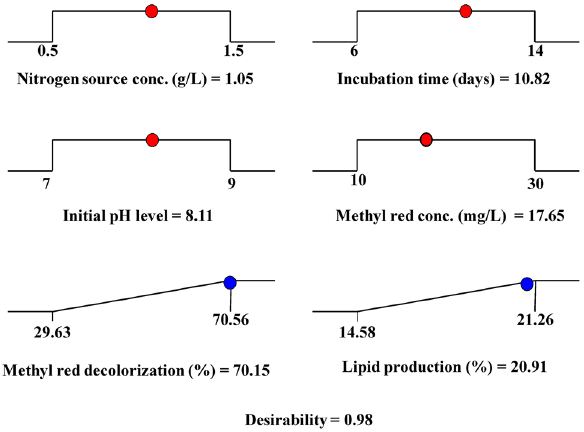
Figure 6. The optimization plot displays the optimum predicted values for the maximum methyl red decolorization (%) and lipid production (%) by using Scenedesmus obliquus and the desirability